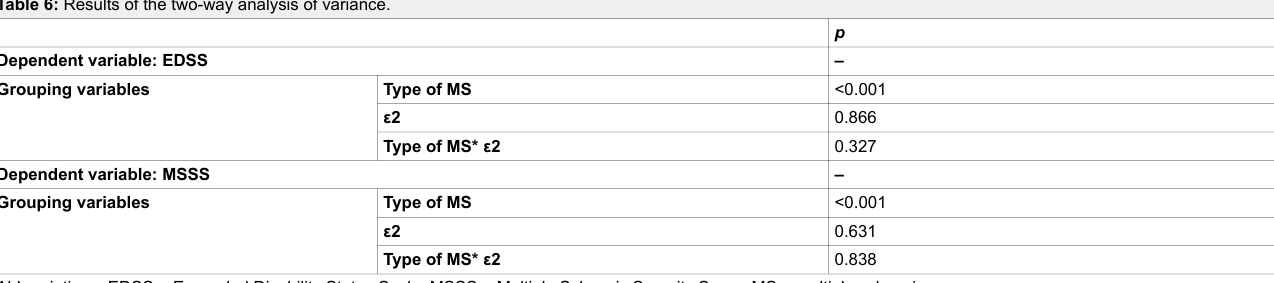
Table 6: Results of the two-way analysis of